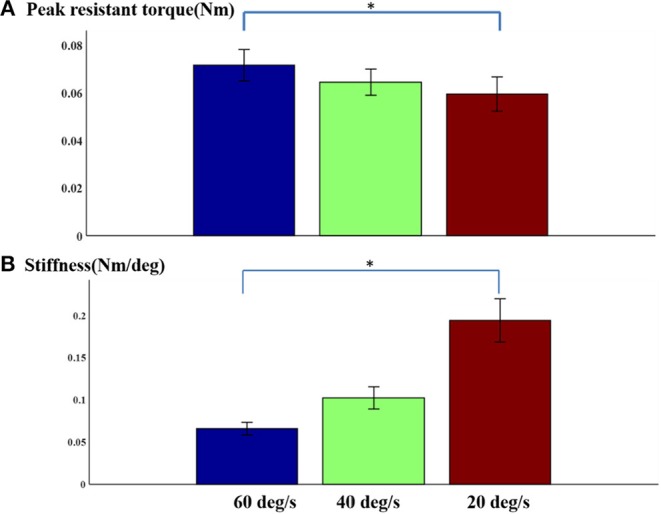
(A) Normalized peak torque and (B) stiffness at three speeds Mean ± SEM, * represents statistical significance).